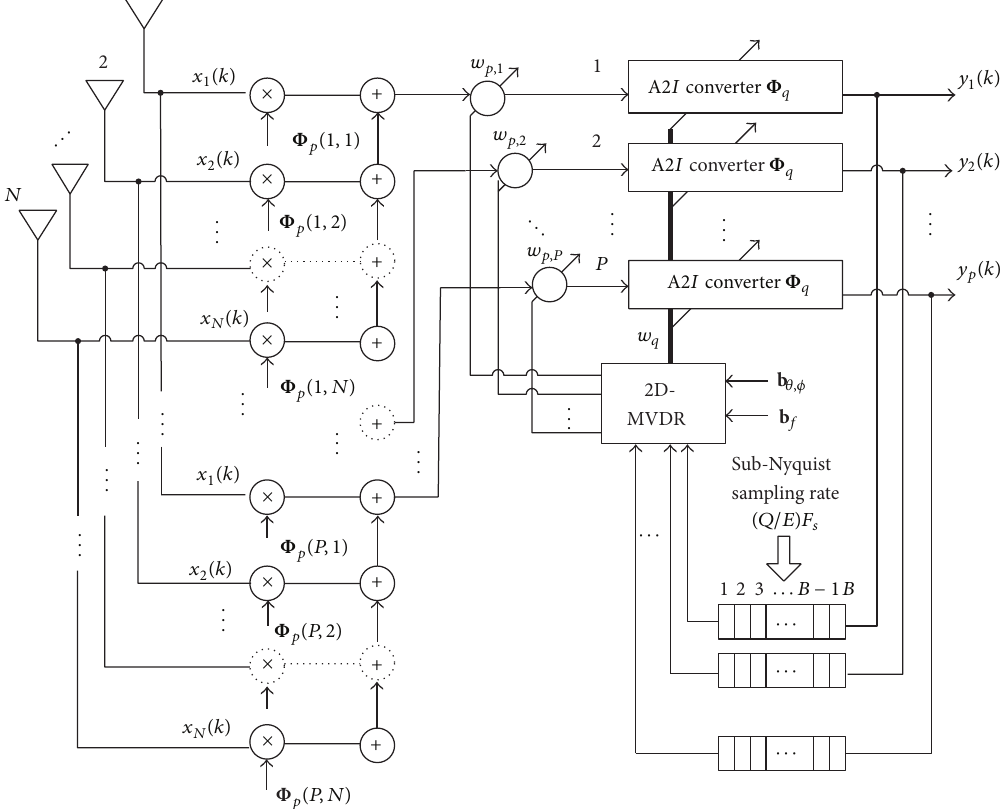
Figure 1: Block diagram of CS based spatial-temporal array